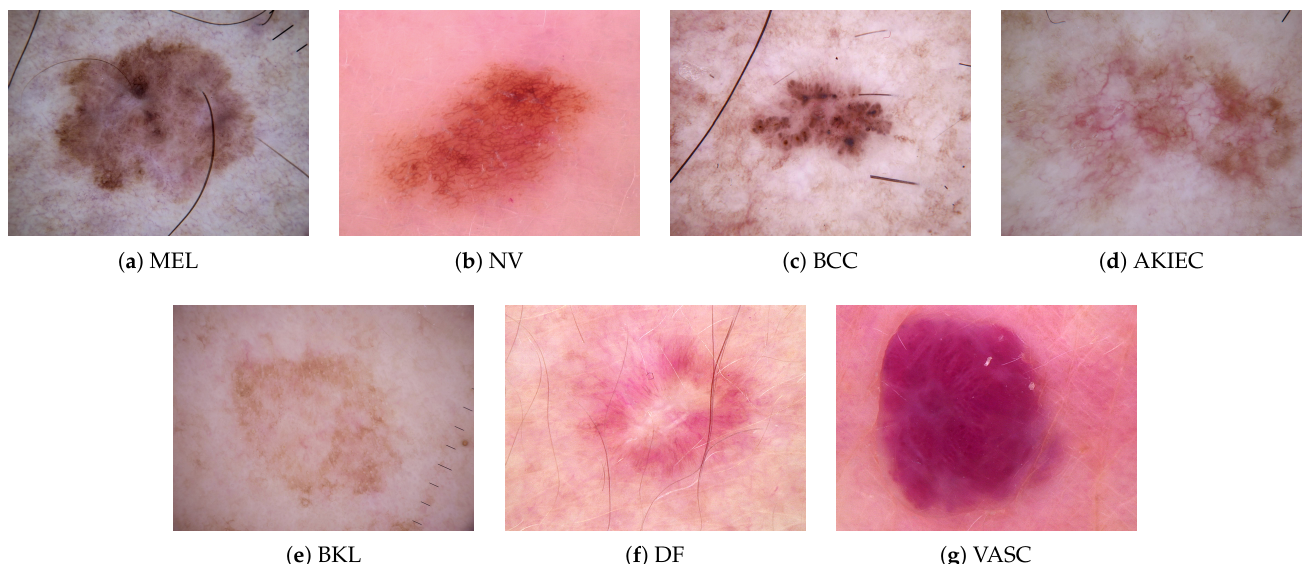
Figure 4. Sample images of the seven types of skin lesions present in the ISIC training datasets. They are melanoma (MEL), melanocytic nevus (NV), basal cell carcinoma (BCC), actinic keratosis (AKIEC), benign keratosis (BKL), dermatofibroma (DF), and vascular lesion (VASC). The number of images for MEL, NV, BCC, AKIEC, BKL, DF, and VASC are 1113, 6705, 514, 327, 1099, 115, and 142, respectively. Reproduced with permission from [32]; published by IEEE,